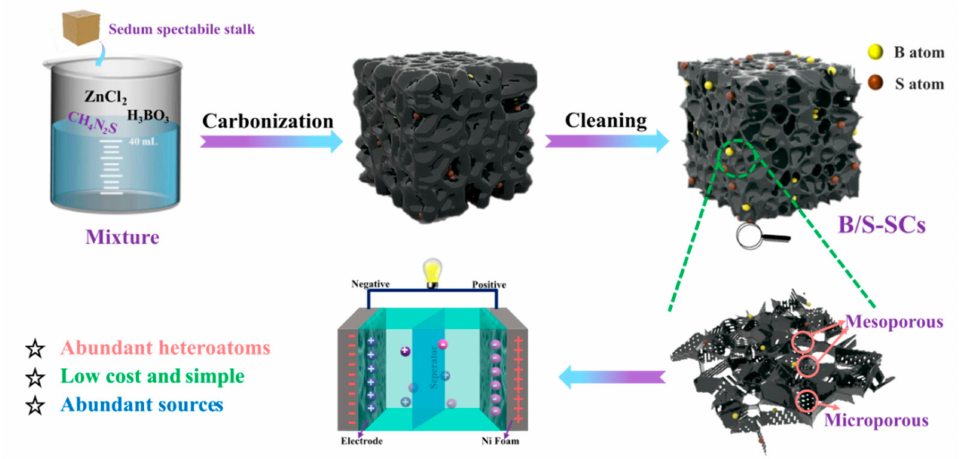
Figure 1. The synthesis route of B/S-SCs